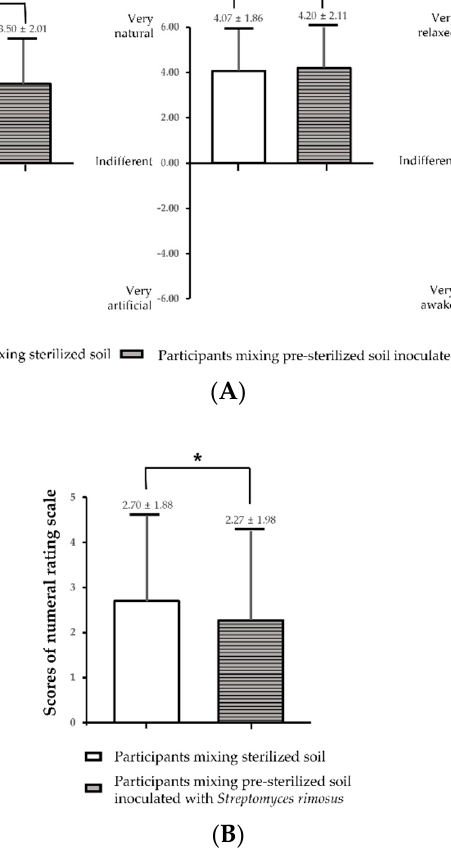
Figure 5. ( A ) Comparisons of the Semantic Differential Method (SDM) for each soil mixing activity. ( B ) Subjective stress evaluation. NRS, numeral rating scale. * p < 0.05, *** p < 0.001, NS p > 0.05 by the paired t -test, respectively. Values are the mean ± SD.